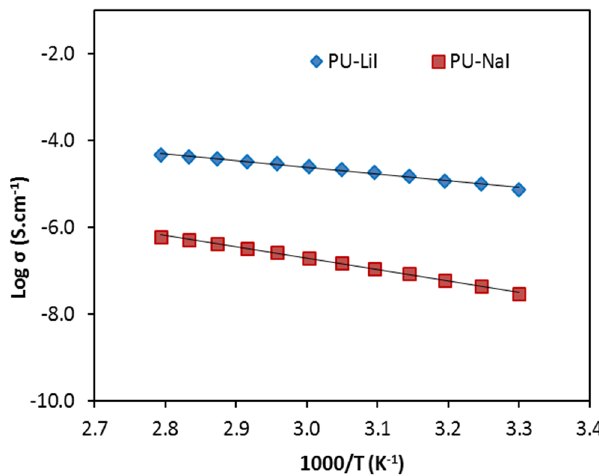
Figure 4. Temperature dependence of ionic conductivity of PU-LiI and PU-NaI polymer